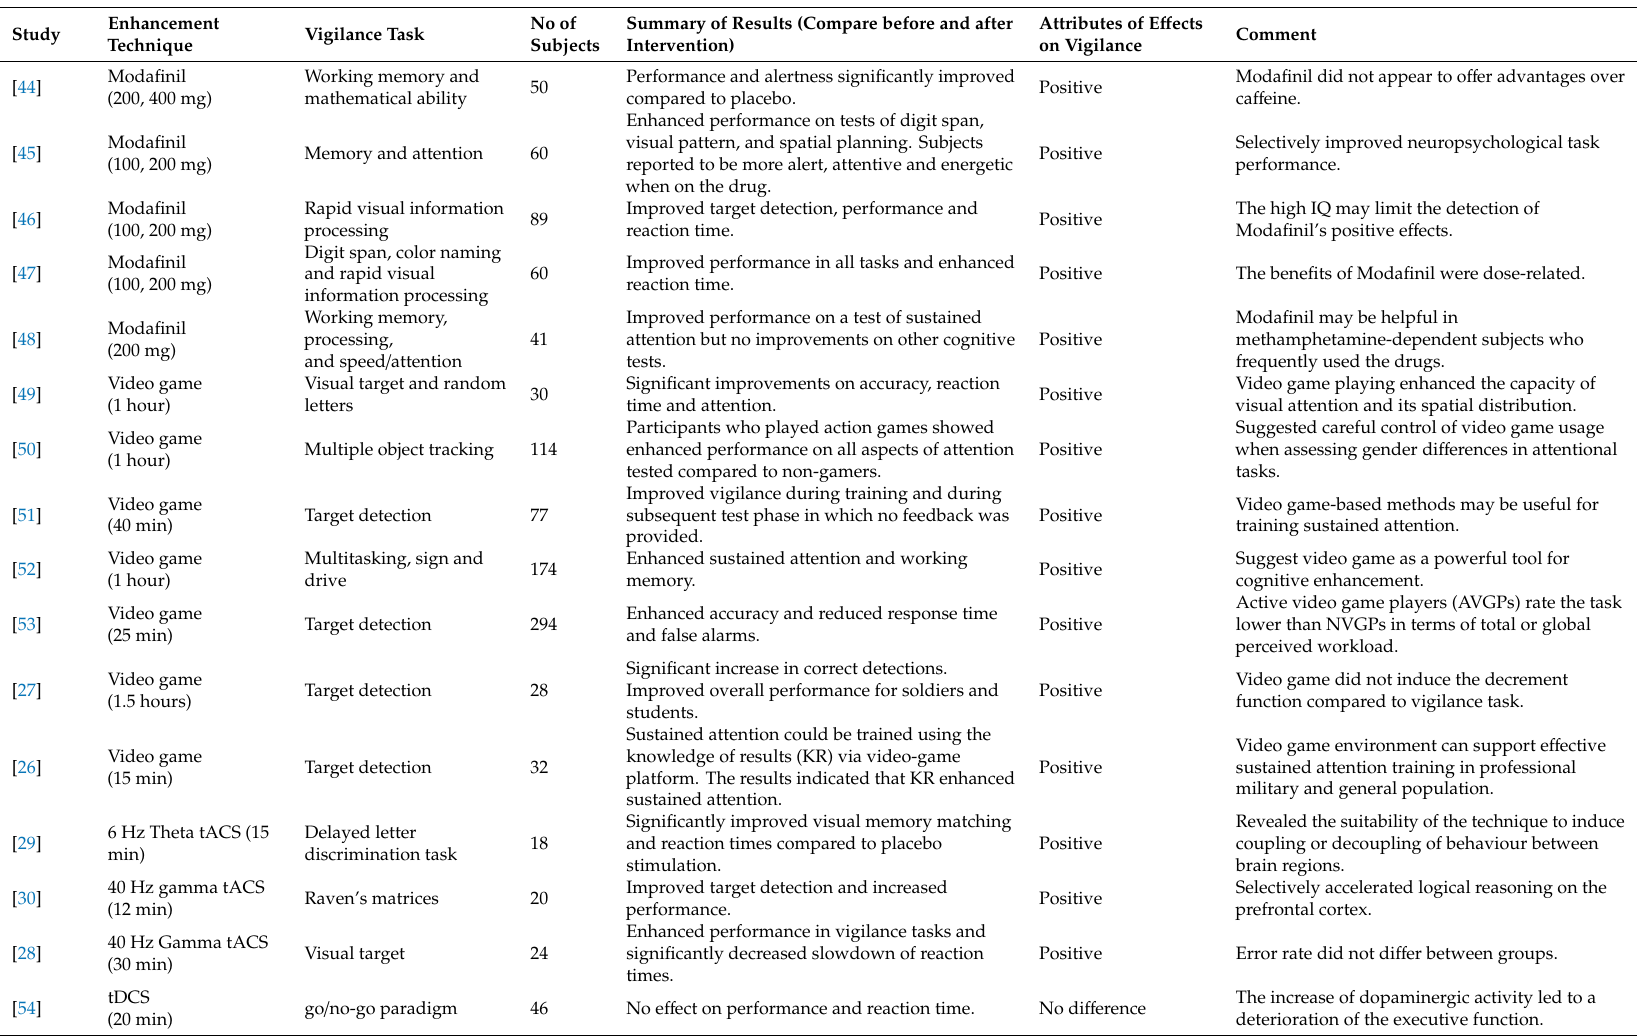
Table 1. Studies of unconventional means of enhancement on